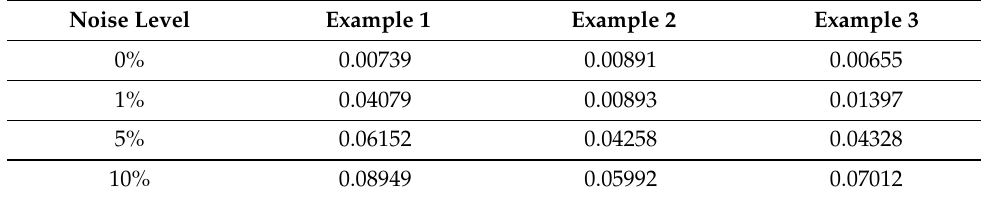
Table 4. The optimal cost with noisy